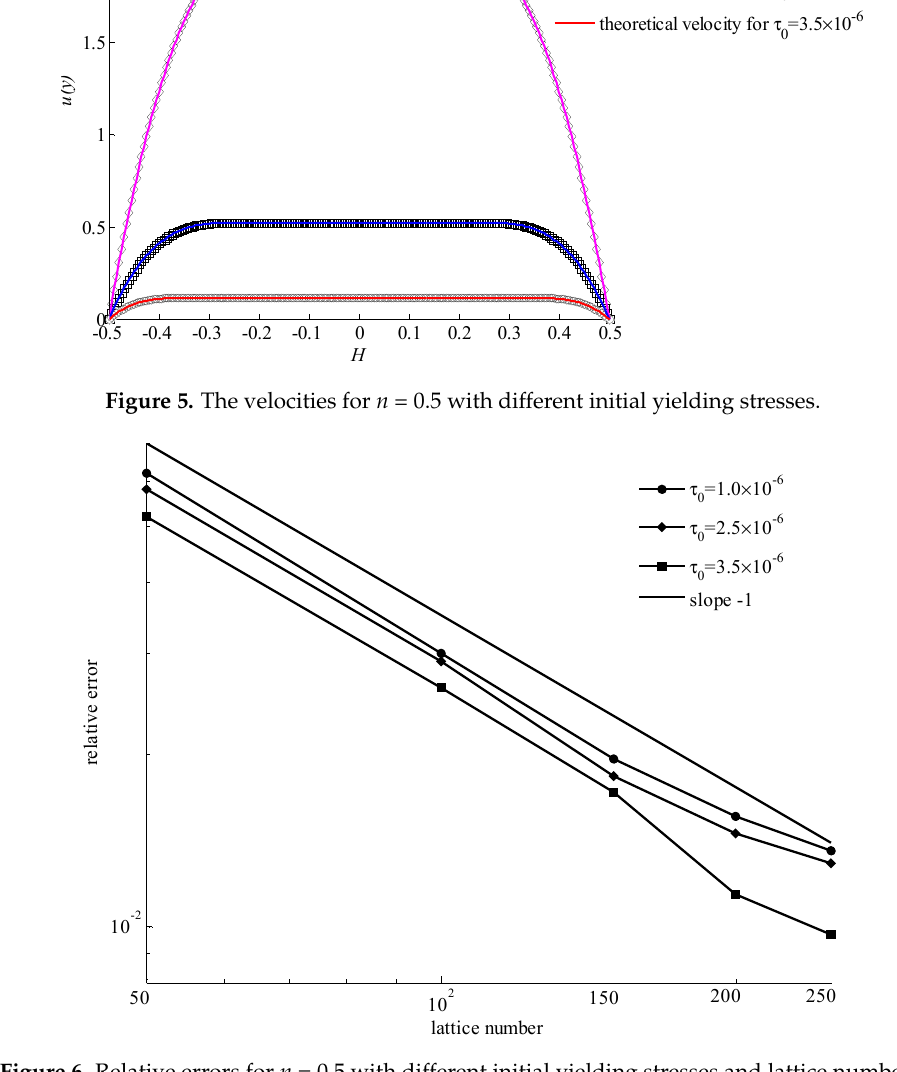
Figure 6. Relative errors for n = 0.5 with different initial yielding stresses and lattice numbers.